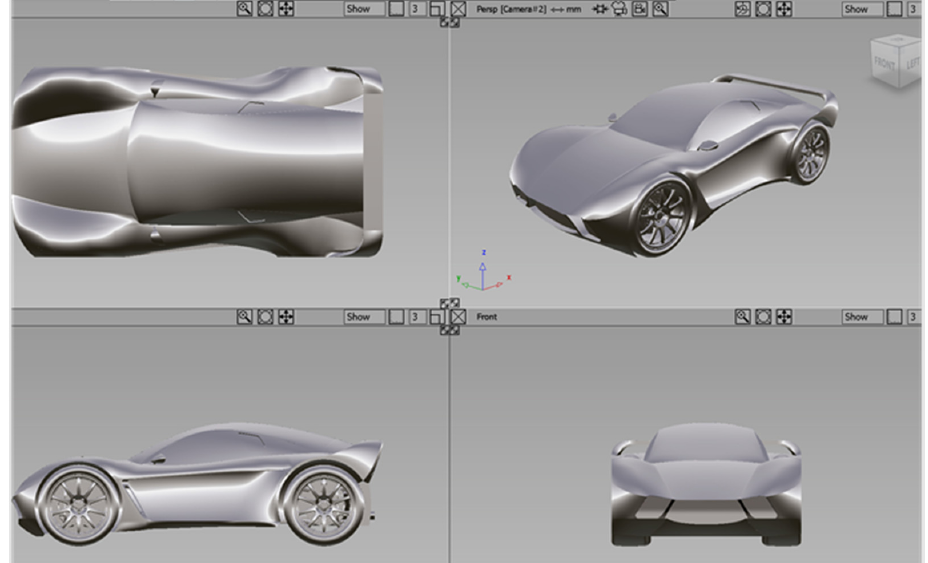
Figure 30. Stone concept 3D Modelling via Autodesk Alias Autostudio.